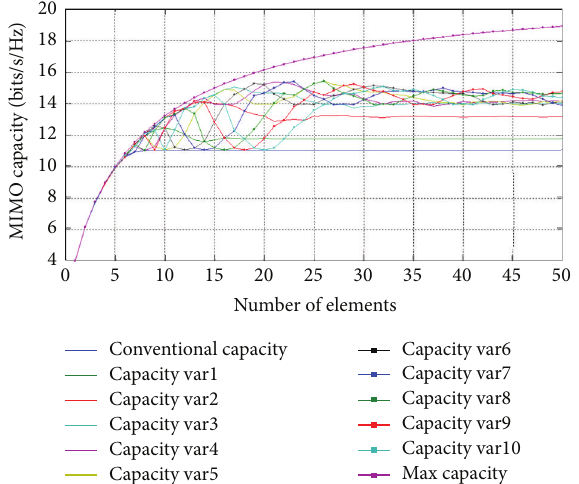
Figure 10: MIMO capacity for the circumference geometry with a SNR = 15dB and a radius of 0.1 𝑑